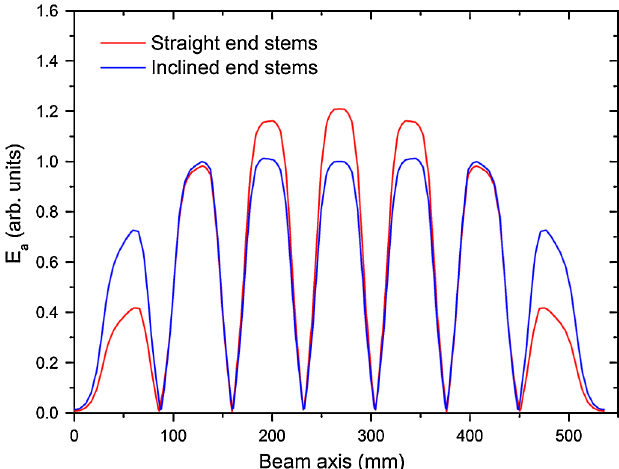
FIG. 4. (Color) Simulation of the electric field distribution for different end stem